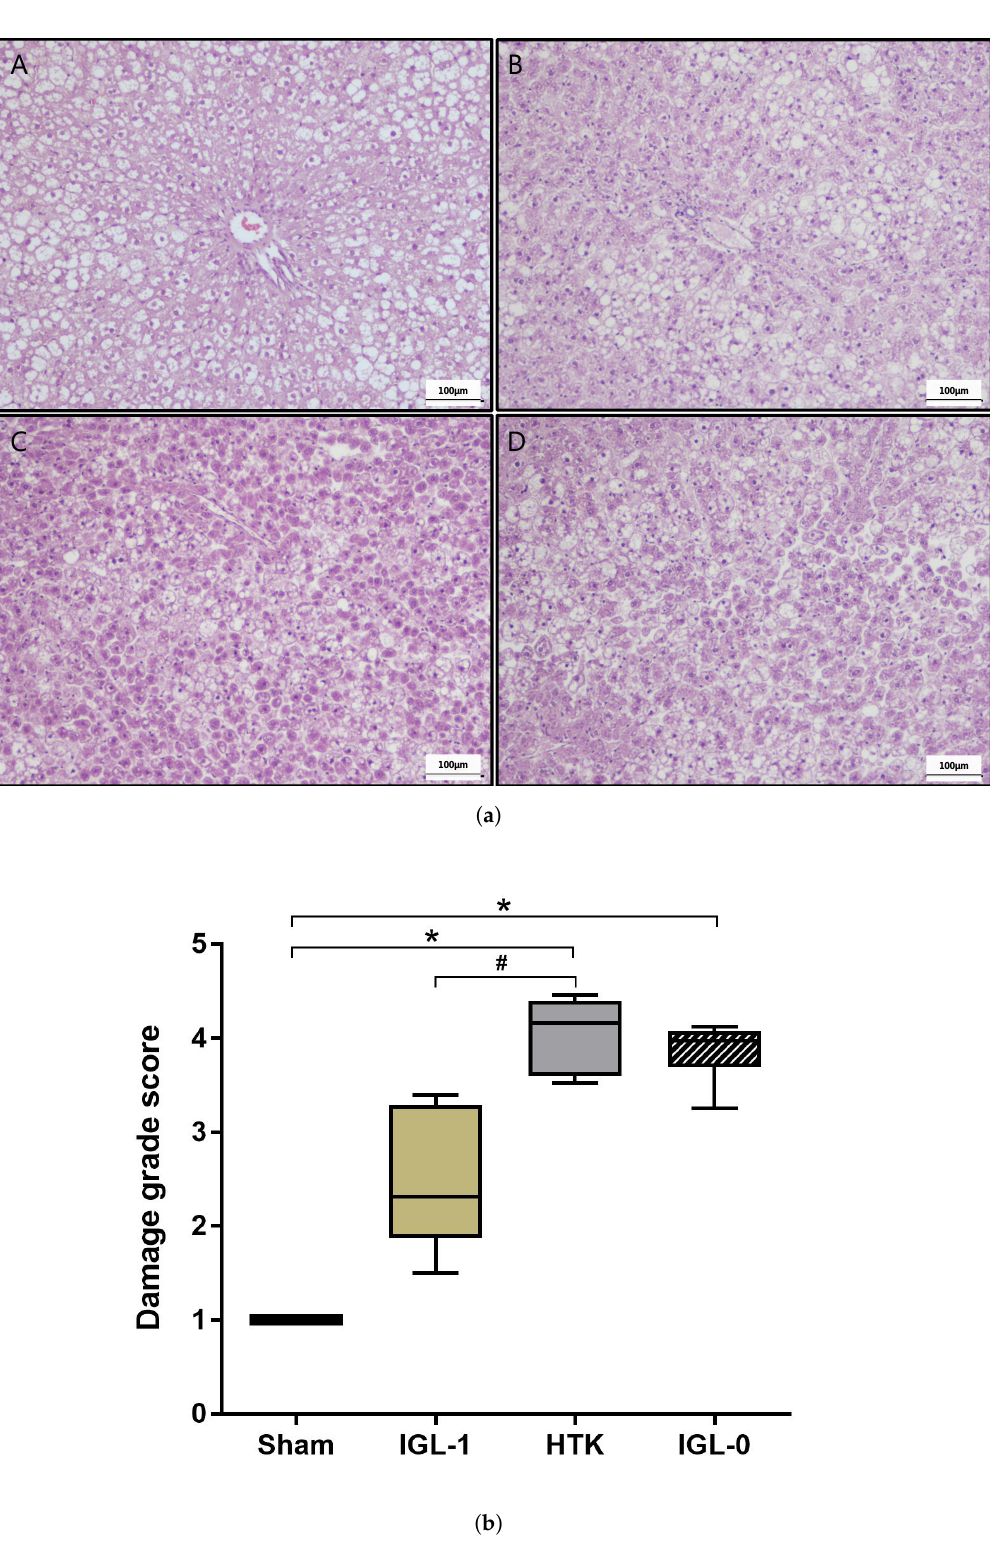
Figure 2. Fatty livers histology after cold ischemia. ( a ) Tissue samples were stained with HES ( × 10). Using Sham group ( A ) as a reference, IGL-1 group ( B ) showed less histological injury (i.e., cell dissociation, loss of hepatic architecture, swollen hepatocytes) than HTK ( C ) and IGL-0 ( D ) groups. ( b ) Damage grade score was made according to the preservation state of the samples evaluated by a pathologist ( E ). * p < 0.05 vs. Sham; # p < 0.05 vs. IGL-1 (Kruskal–Wallis